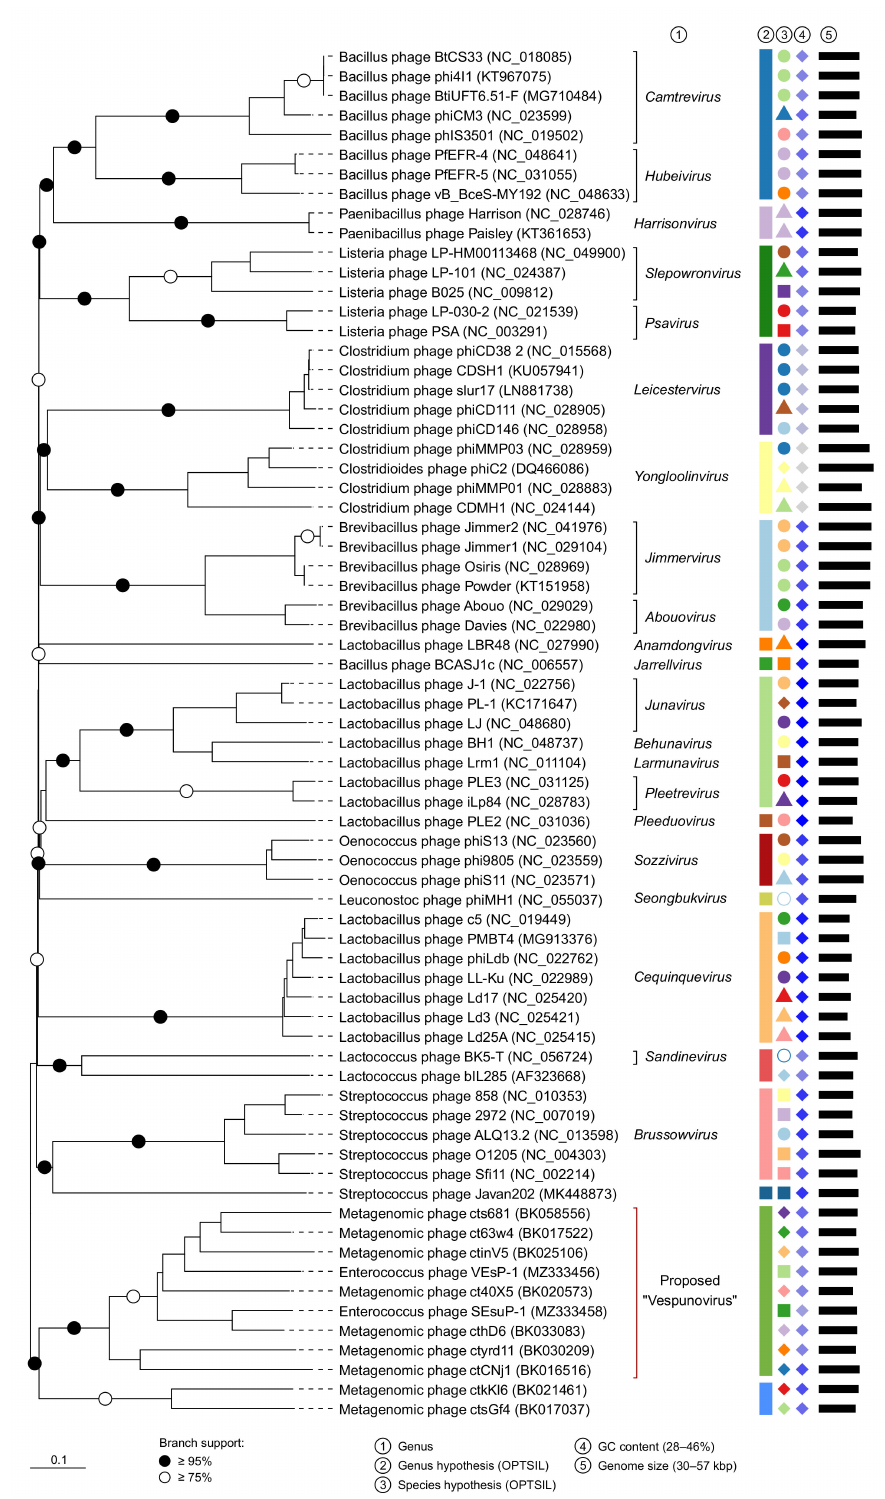
Figure 4. VICTOR phylogenomic tree. The group of VEsP-1-related bacteriophages predicted in vContact2 analysis belong to the same “Vespunovirus” genus